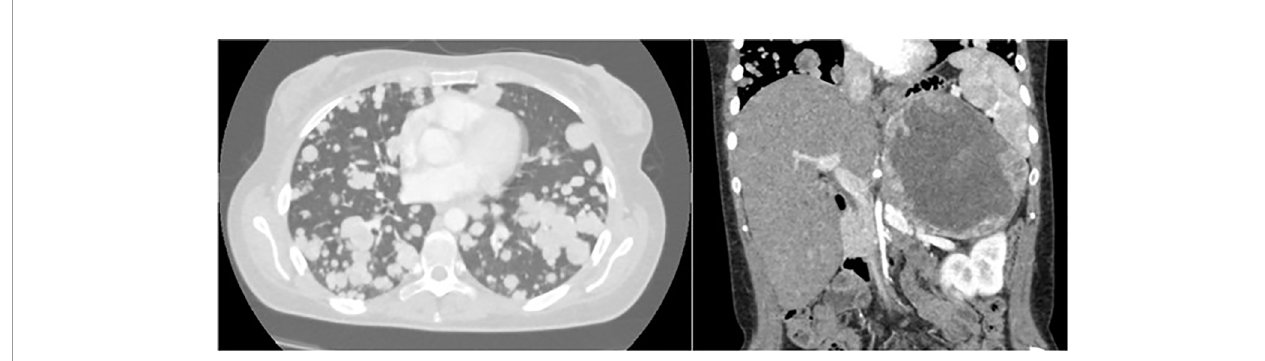
FIGURE 1 | Multiple pulmonary metastases and adrenal mass detected by CT Scan (January